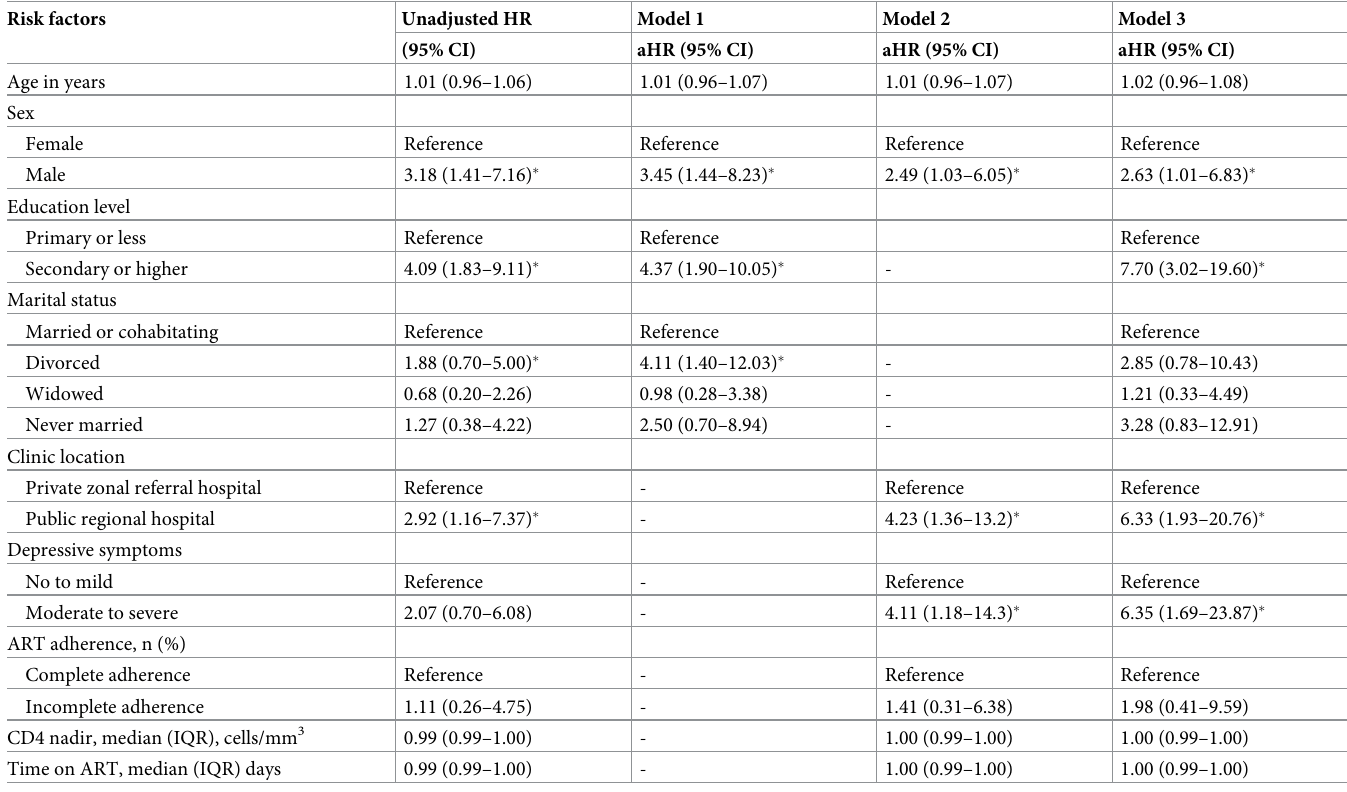
Table 2. Multivariable analysis of risk factors for death among a cohort of HIV-infected patients on antiretroviral therapy in northern Tanzania,